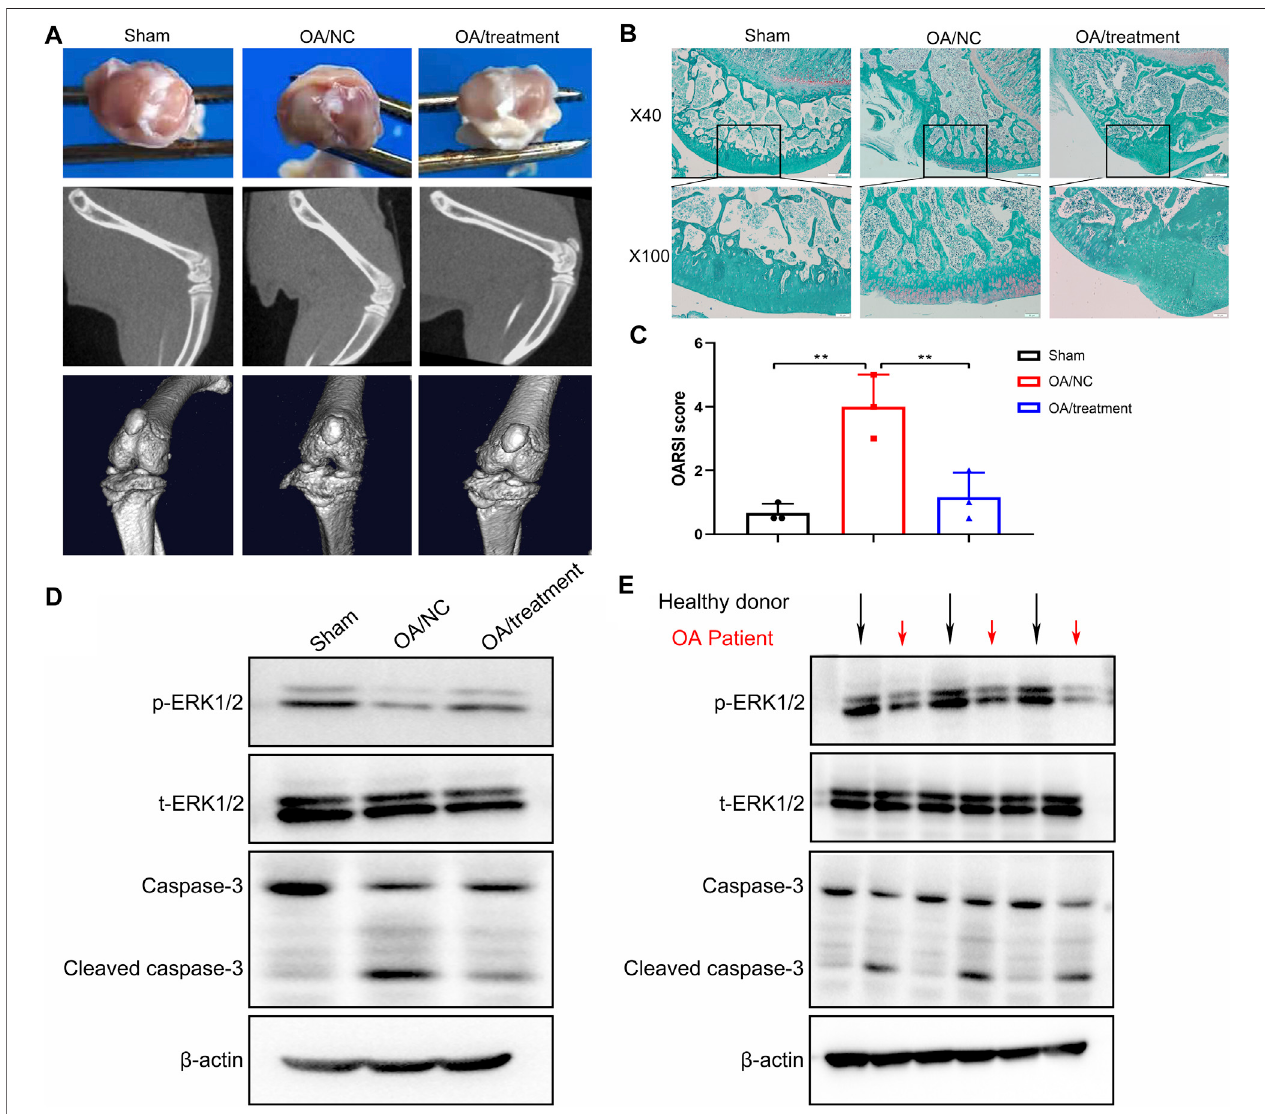
FIGURE 8 | Sivelestat decreased apoptosis of articular chondrocytes and impeded the loss of cartilage in the knee joint from neutrophil elastase induced rat osteoarthritic model. (A) Macroscopic view, micro-CT image and 3D image of the specimens from sham group, OA model group and treatment groups. (B) Representative safranin O-fast green staining of the knee jointin sham group, OAmodel group and treatment groups. (C) OARSI scores based on staining results. Data are mean ± SEM; n (cid:1) 3. ** p < 0.01. (D) Western blot of ERK1/2 phosphorylation, total ERK1/2, caspase-3 and cleaved caspase-3 levels of articular cartilage from ratmodel. (E) WesternblotofERK1/2phosphorylation,totalERK1/2,caspase-3andcleavedcaspase-3levelsofarticularcartilagefromhealthydonorsandOApatients.